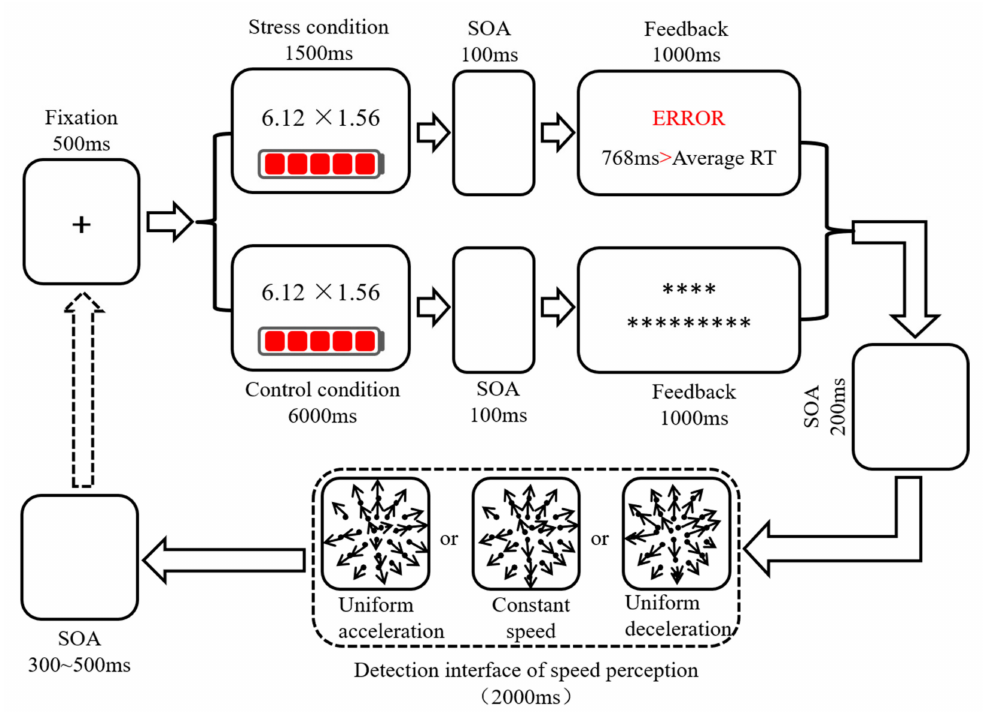
Figure 1. Schematic diagram of the experimental procedure of stress-inducing and speed perception. “*” was the content of